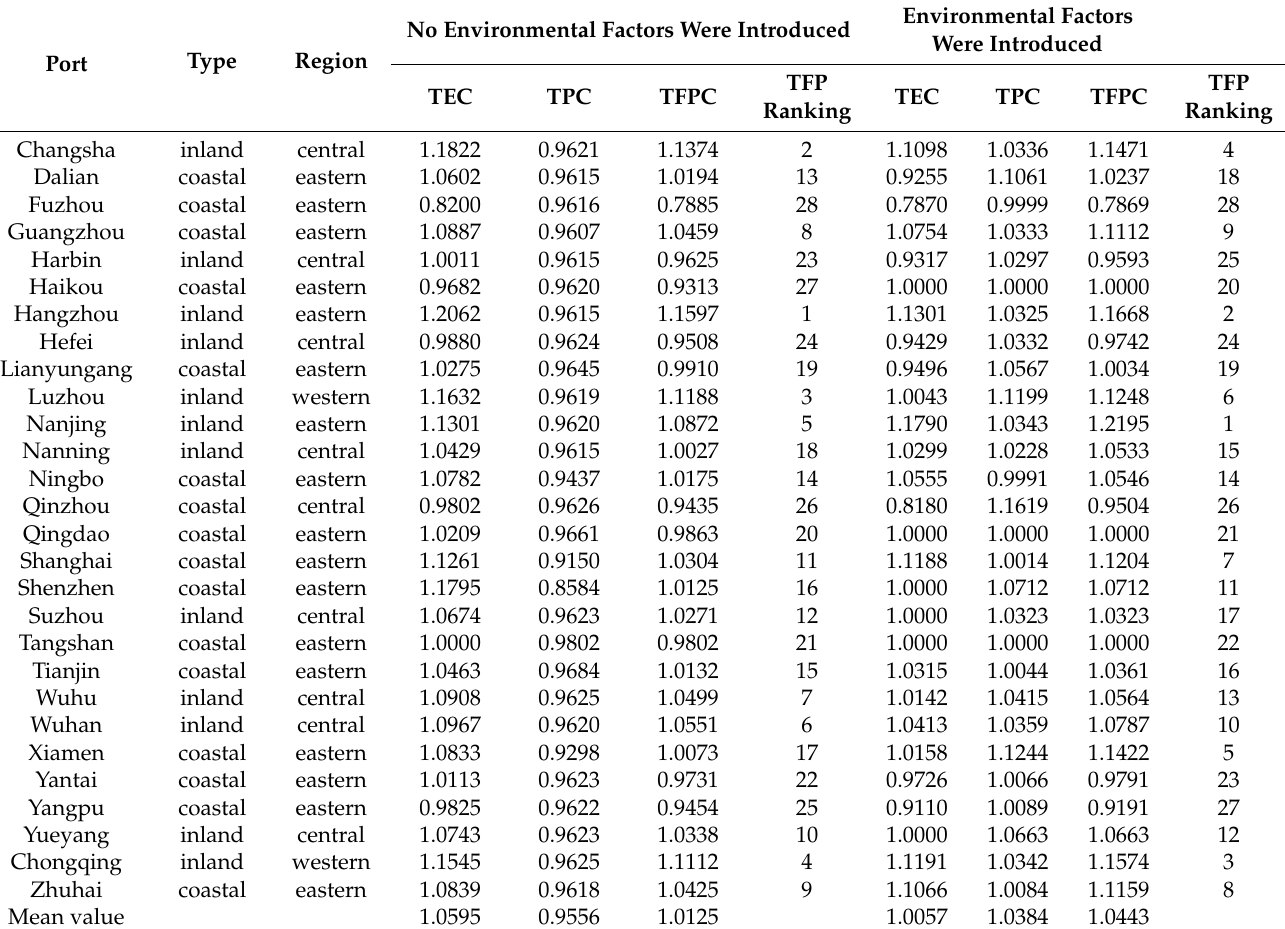
Table 4. TFP index of each port and its decomposition term